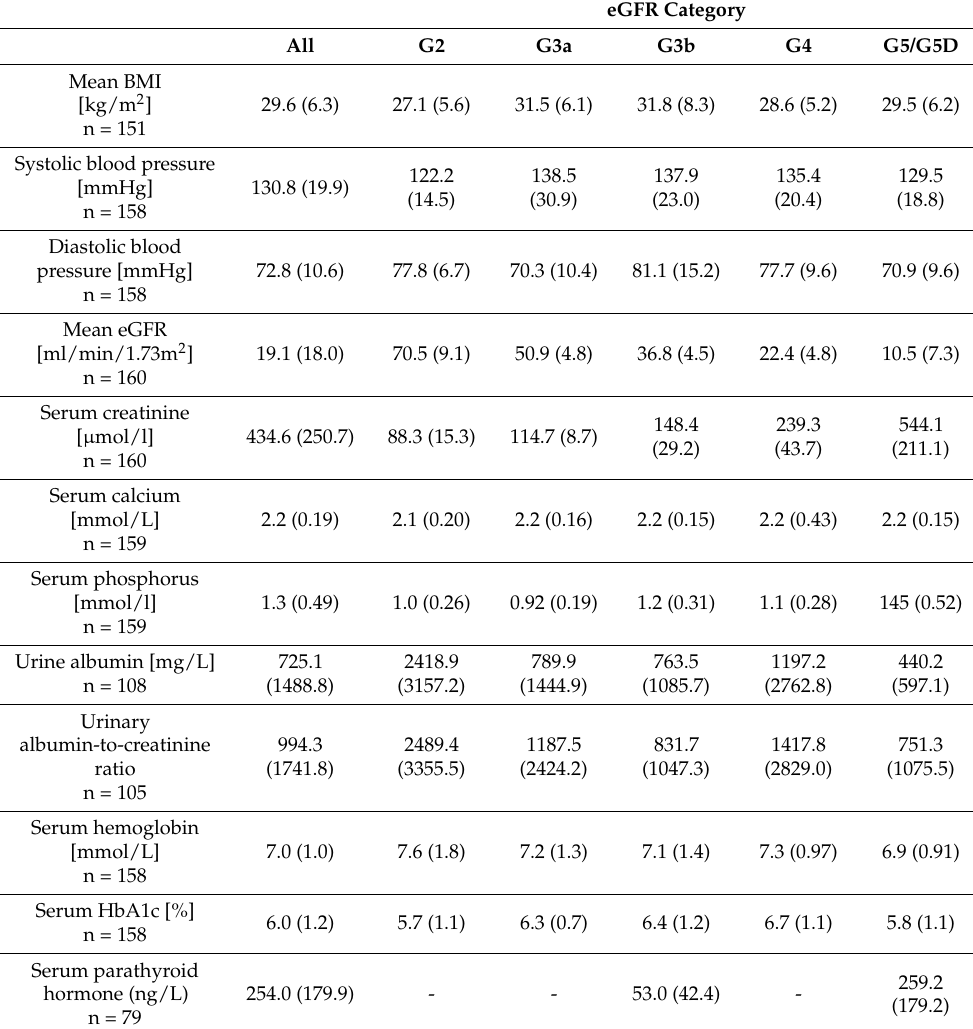
Table 2. Physiological parameters and laboratory